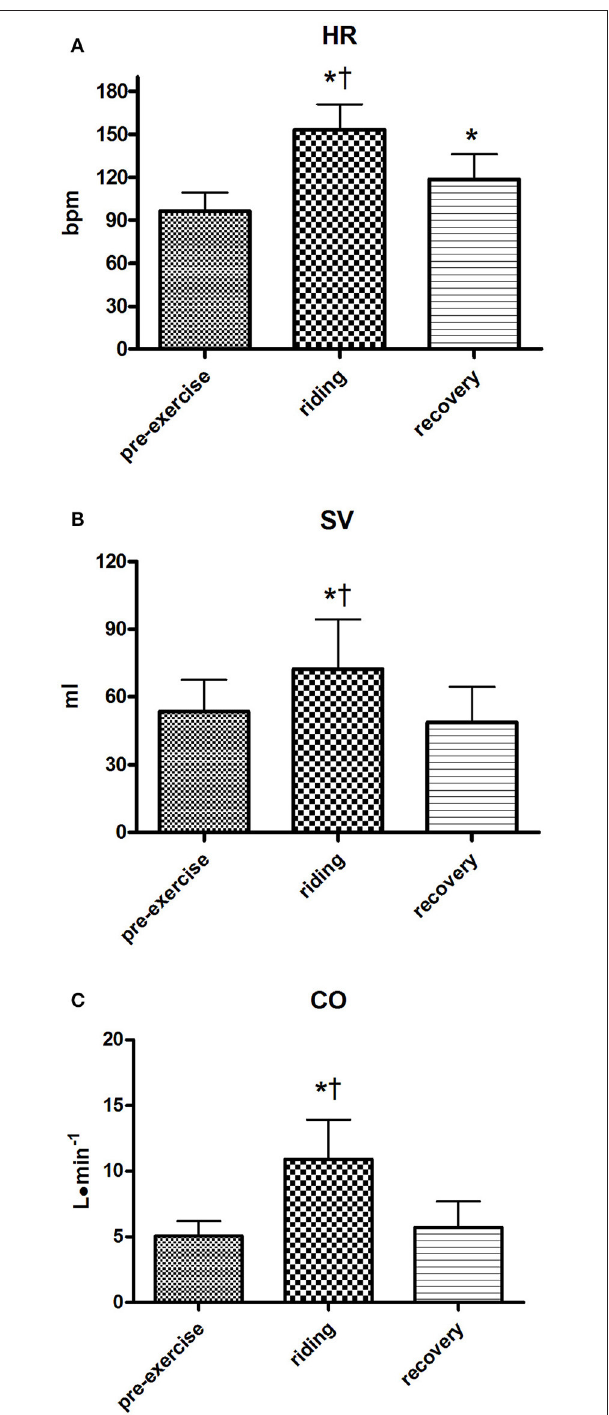
FIGURE 3 | Group heart rate values (HR, A ), stroke volume (SV, B ), and cardiac output (CO, C ) during the various periods of the Enduro session. Variables at rest were considered those of the last minute of rest preceding the motorcycle session, variables during riding were the average of the 10min Enduro session, while variables at recovery were considered those of the third minute of recovery. Values are mean ± SD ( n = 15). * p < 0.05 vs. pre-exercise; † p < 0.05 vs.